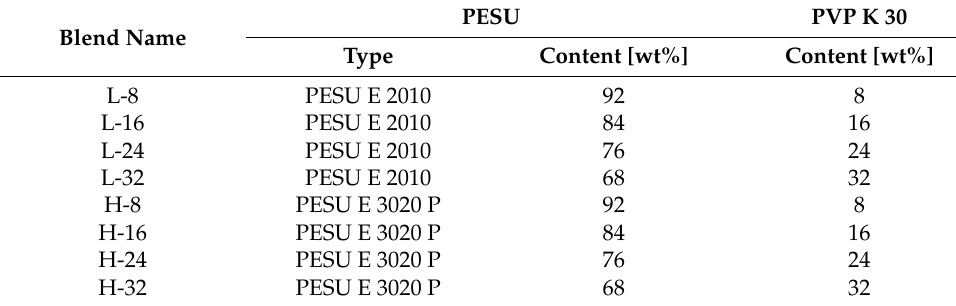
Table 1. Nomenclature of blends with respect to their